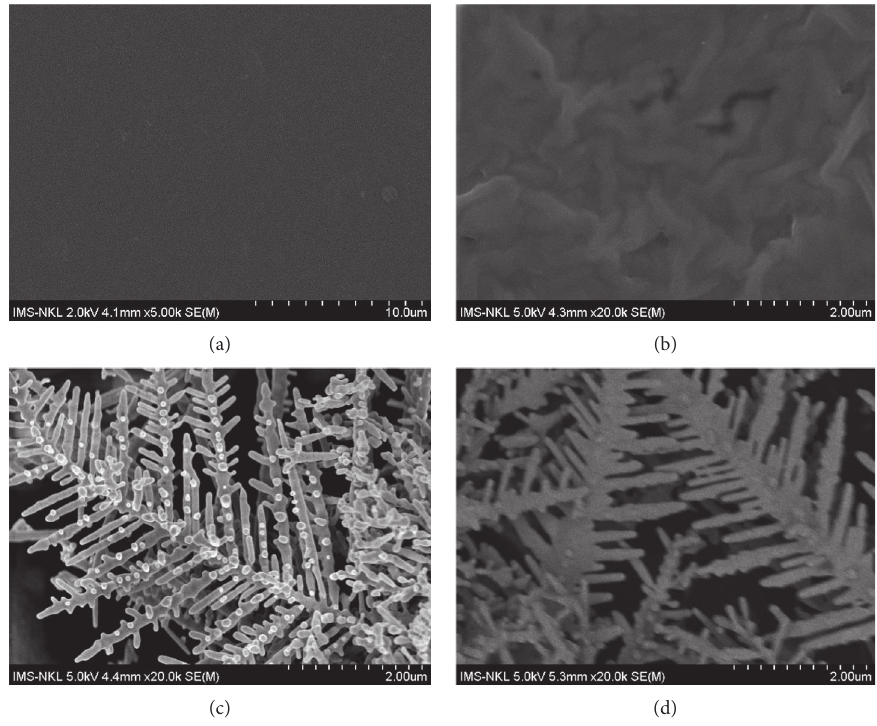
Figure 1: SEM images of (a) GCE, (b) CTAB/GCE, (c) AuNDs/GCE, and (d) AuNDs/CTAB/GCE samples.